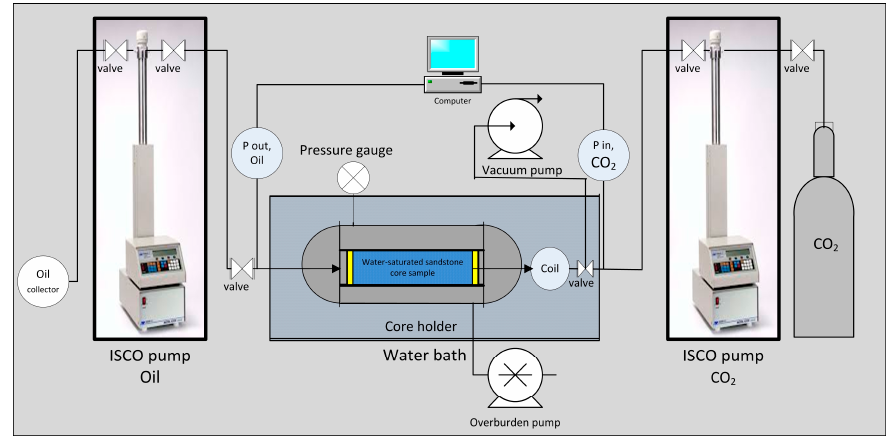
Figure 2. The experimental setup for CO 2 (gas-liquid-supercritical)–oil displacements.